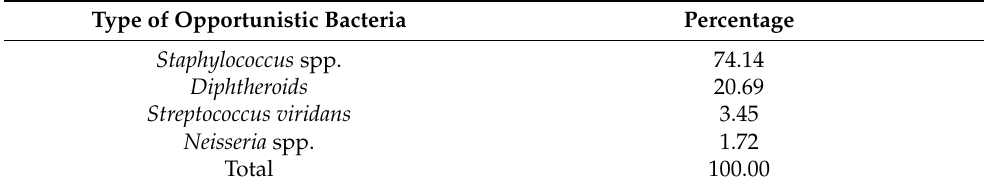
Table 7. Type and percentage of opportunistic bacteria in exudate collected from the middle ear space.